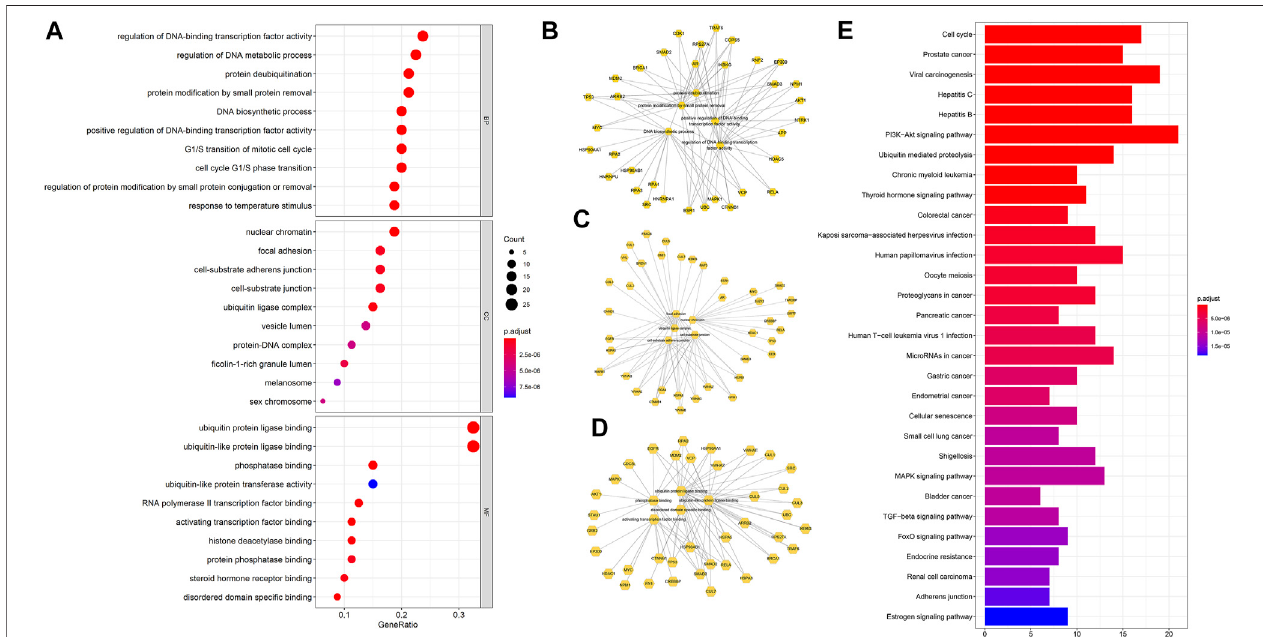
FIGURE5| Thetop10terms ofGOanalysisabout targets involvedinthe corenetwork (A) . (B) Sub-network showing thetop fi ve BPtermsand related genes; (C) Sub-network showing the top 5 CC terms and related genes; (D) Sub-network showing the top fi ve MF terms and related genes. (E) The top 30 KEGG pathway enrichment of core targets of YZQX against AD with depression. Pathways that had signi fi cant changes of p. adjust < 0.05 were identi fi ed. The dot size represents a number of genes and color represents the p. adjust value.